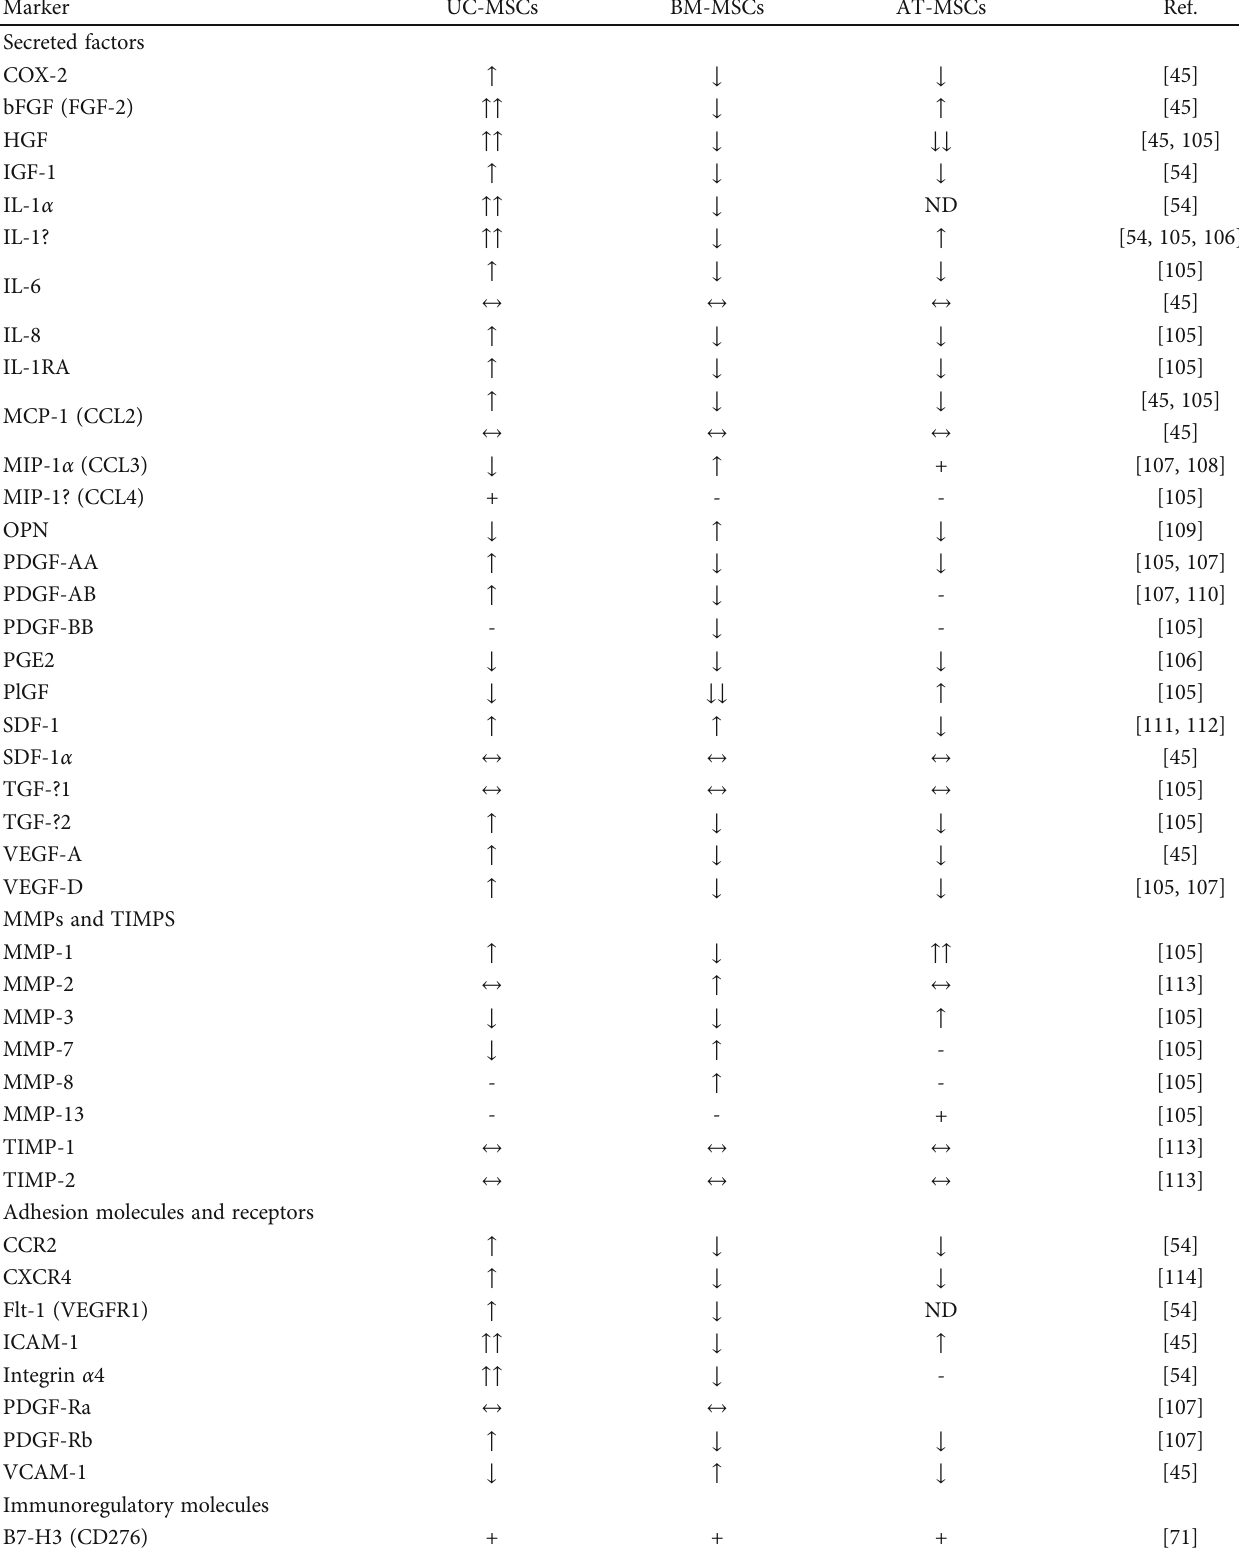
Table 2: Expression analysis of di ff erent markers involved in homing and